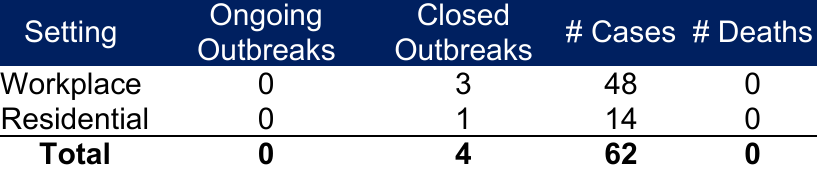
Table 1. Community outbreaks of confirmed COVID-19 in Ottawa